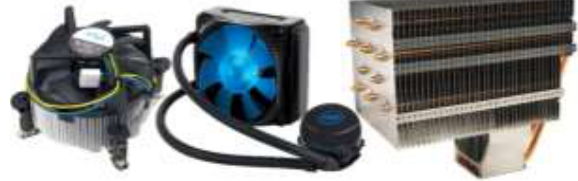
Fig. 2. Types of cooling: air circulation, water cooling, heat pipe